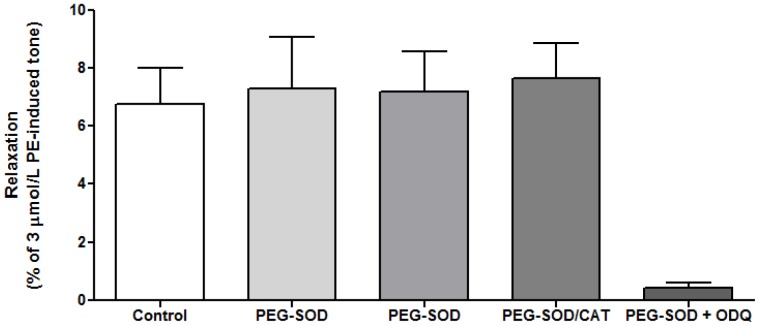
Effect of O2
− and H2O2 on vessel relaxation in hypoxia.The inhibition of O2
− radicals (100 U/ml PEG-SOD) and H2O2 (250 U/ml PEG-CAT) within the vessel system did not affect the magnitude of the relaxation to a bolus of 95% oxygenated buffer. PEG-SOD (100 U/ml) plus ODQ (10 µmol/L) abolished most of the relaxation (*p<0.05 cf. control). All n = 3.